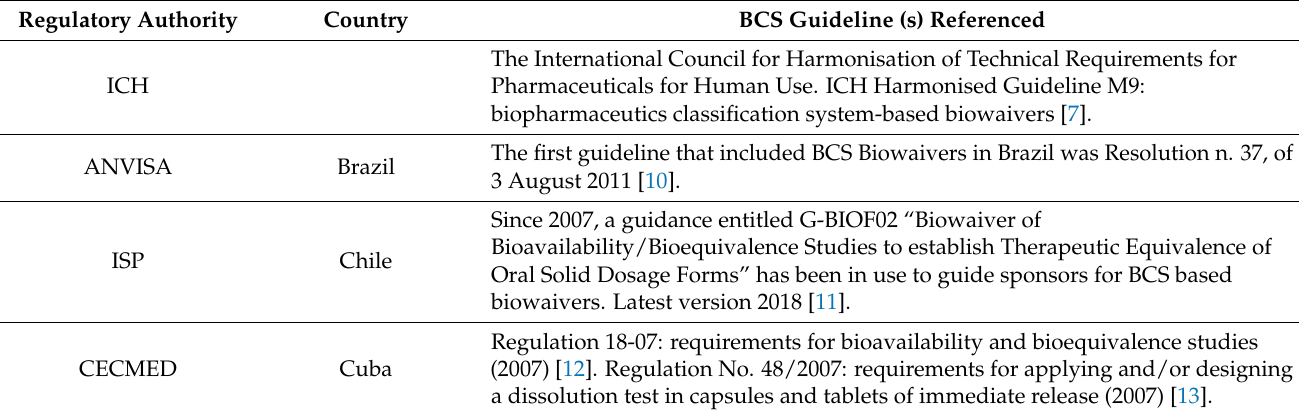
Table 1. Official and publicly available Biopharmaceutical Classification System (BCS) guidelines from the International Council for the Harmonization of Technical Requirements for Pharmaceuticals for Human Use (ICH) and Latin American regulatory